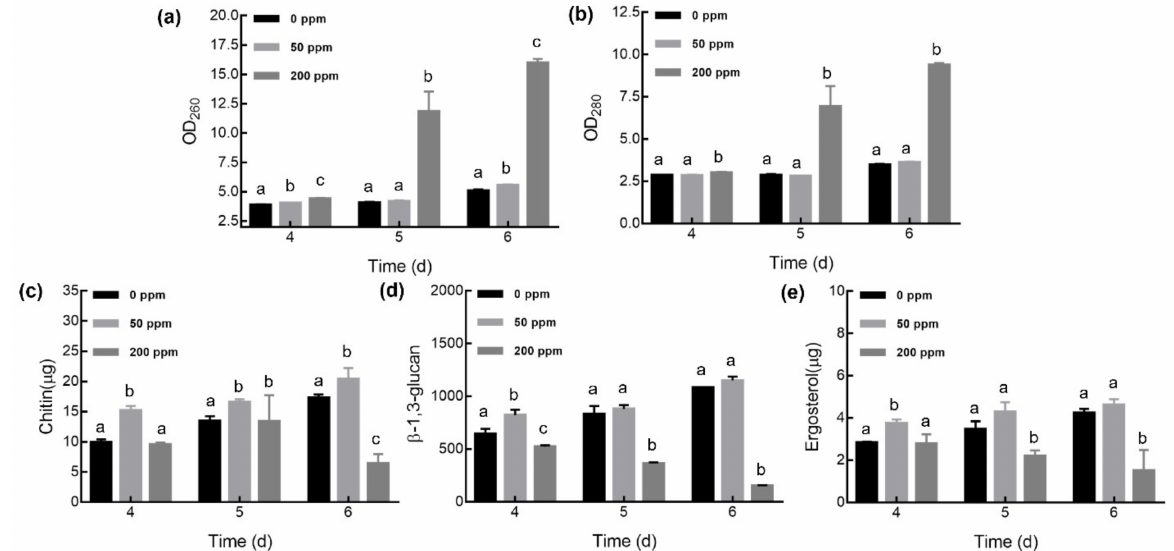
Figure 3. Changes in nucleic acid ( a ) and protein ( b ) and the cell wall and cell membrane components chitin ( c ), β -1,3-glucan ( d ), and ergosterol ( e ) in Ganoderma lucidum with selenite at different concentrations. The bars indicate the standard error of the mean (different letters indicate a significant difference on the same culture day at p <